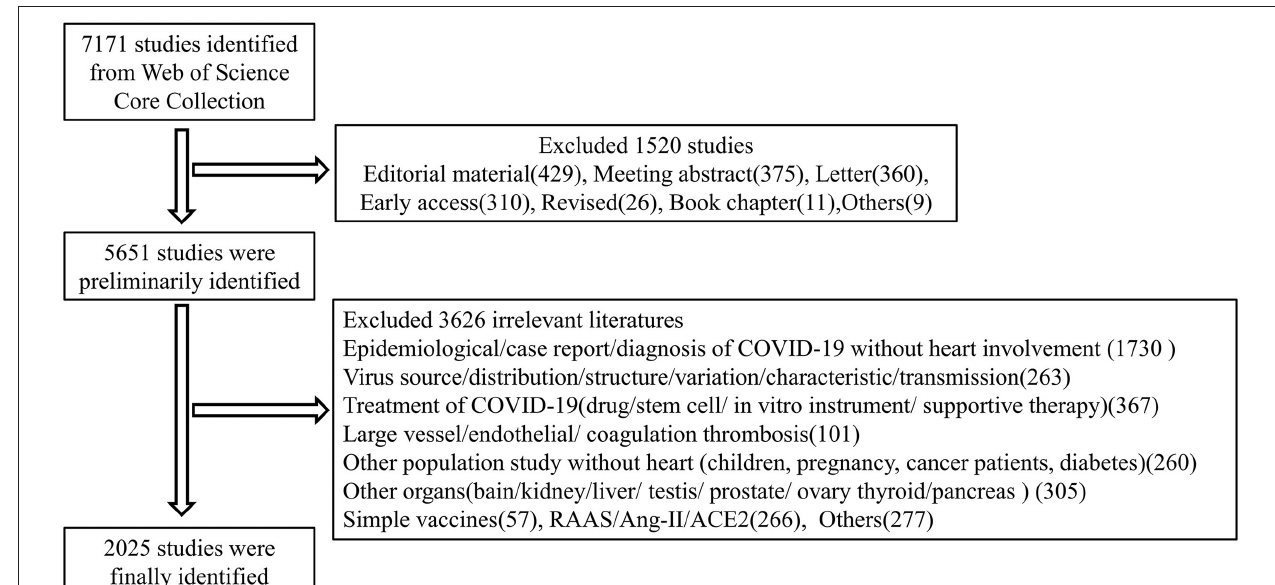
FIGURE 1 | The detailed information of the screening process. All of the relevant studies of COVID-19 and heart were primarily recorded by the initial retrieval in the web of science. Only articles and reviews were selected for the second analysis. We eliminated invalid documents of which the themes were not related to COVID-19 and heart. Finally, a total of 2025 records were used as the dataset in the final study.